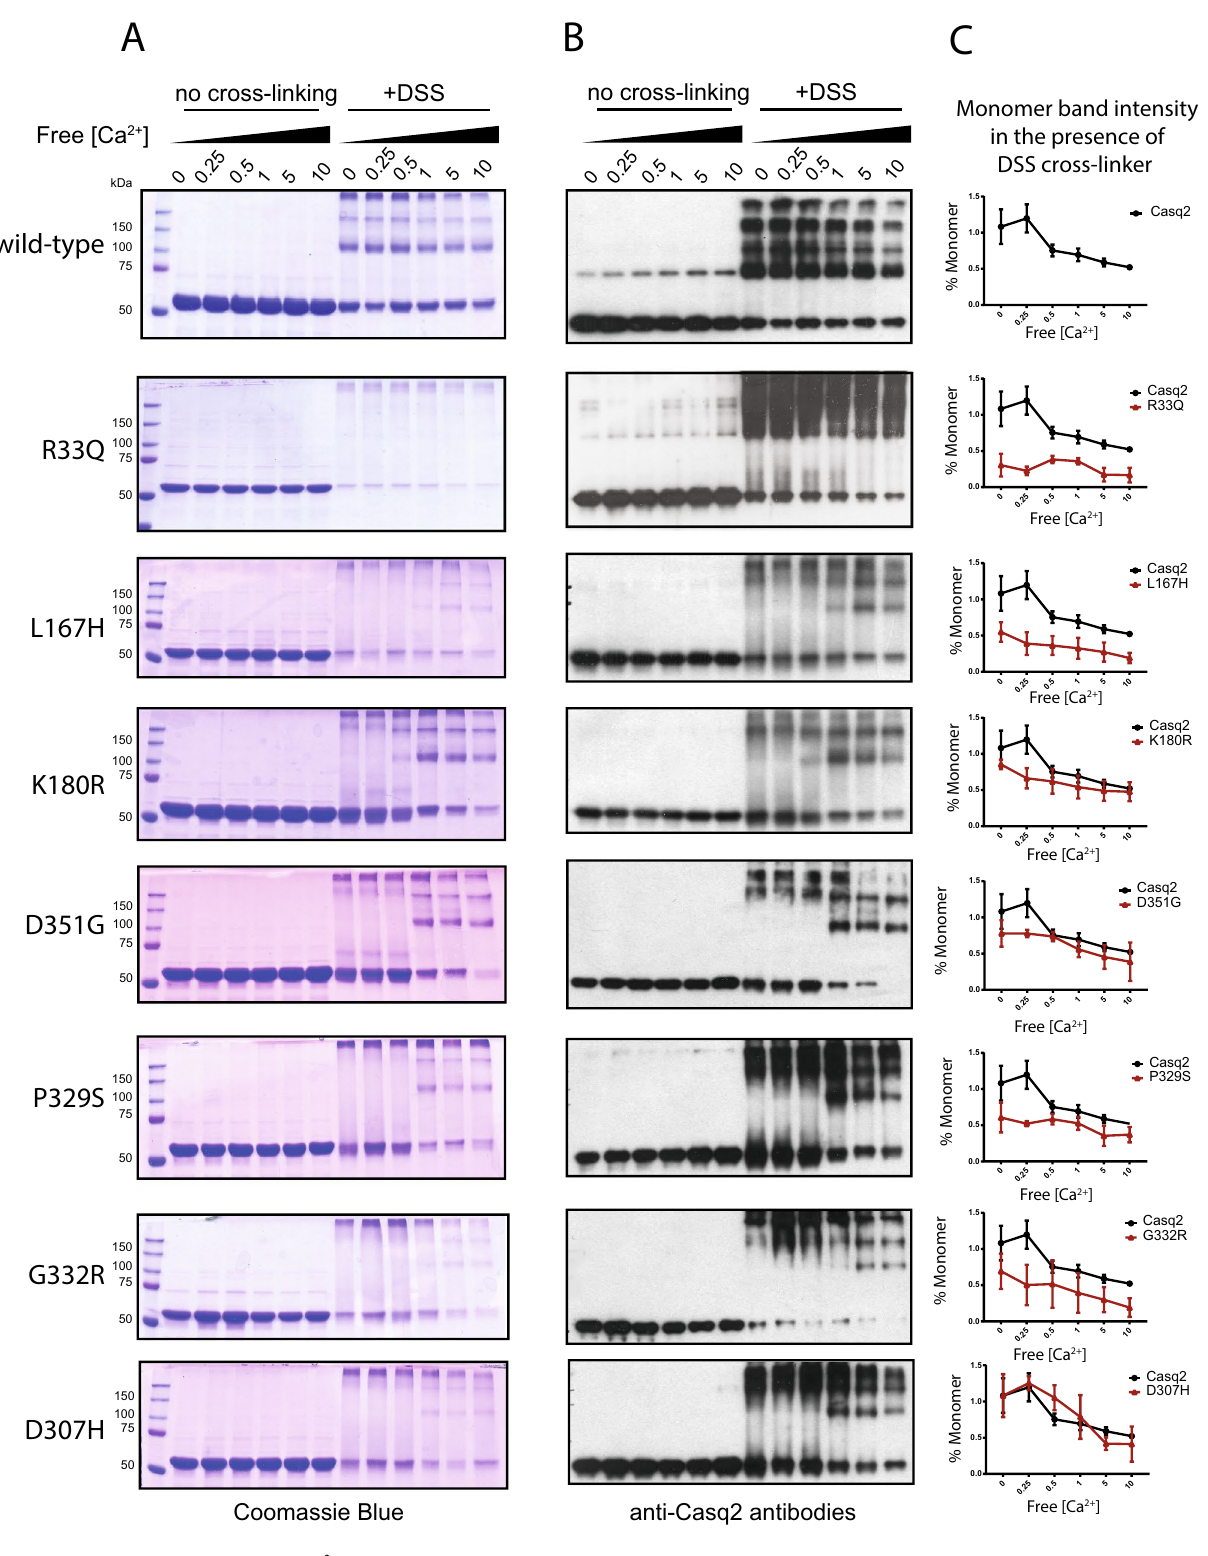
Figure 7. Ca 2+ -dependent polymerization of Casq2 and Casq2 mutants. ( A ) Coomassie blue stained SDS- PAGE of Casq2 and Casq2 mutant incubated with or without cross-linker at increasing free Ca 2+ concentration. ( B ) Immunoblots were probed with anti-Casq2 antibodies. The full-length blots are shown in Figs. S4 and S5. ( C ) Quantitative analysis of Casq2 monomer (~ 50 kDa protein band) of wild-type or mutant proteins in the presence of cross-linker (from A ) as a function of increased free Ca 2